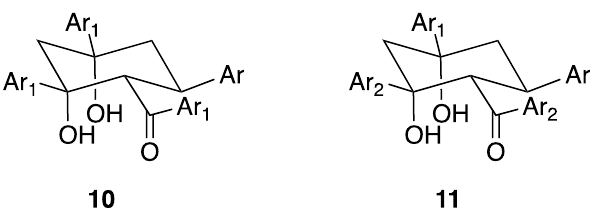
Figure 11. The structures of the 3:1 cyclohexane-1,3-diol derivatives arising from the condensation of the pentane-1,5-dione with Ar 1 COCH 3 .